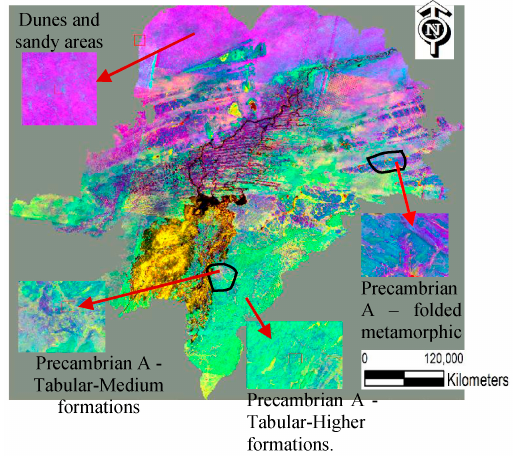
Figure 5. RGB image obtained with Principal Components (PCs) bands.